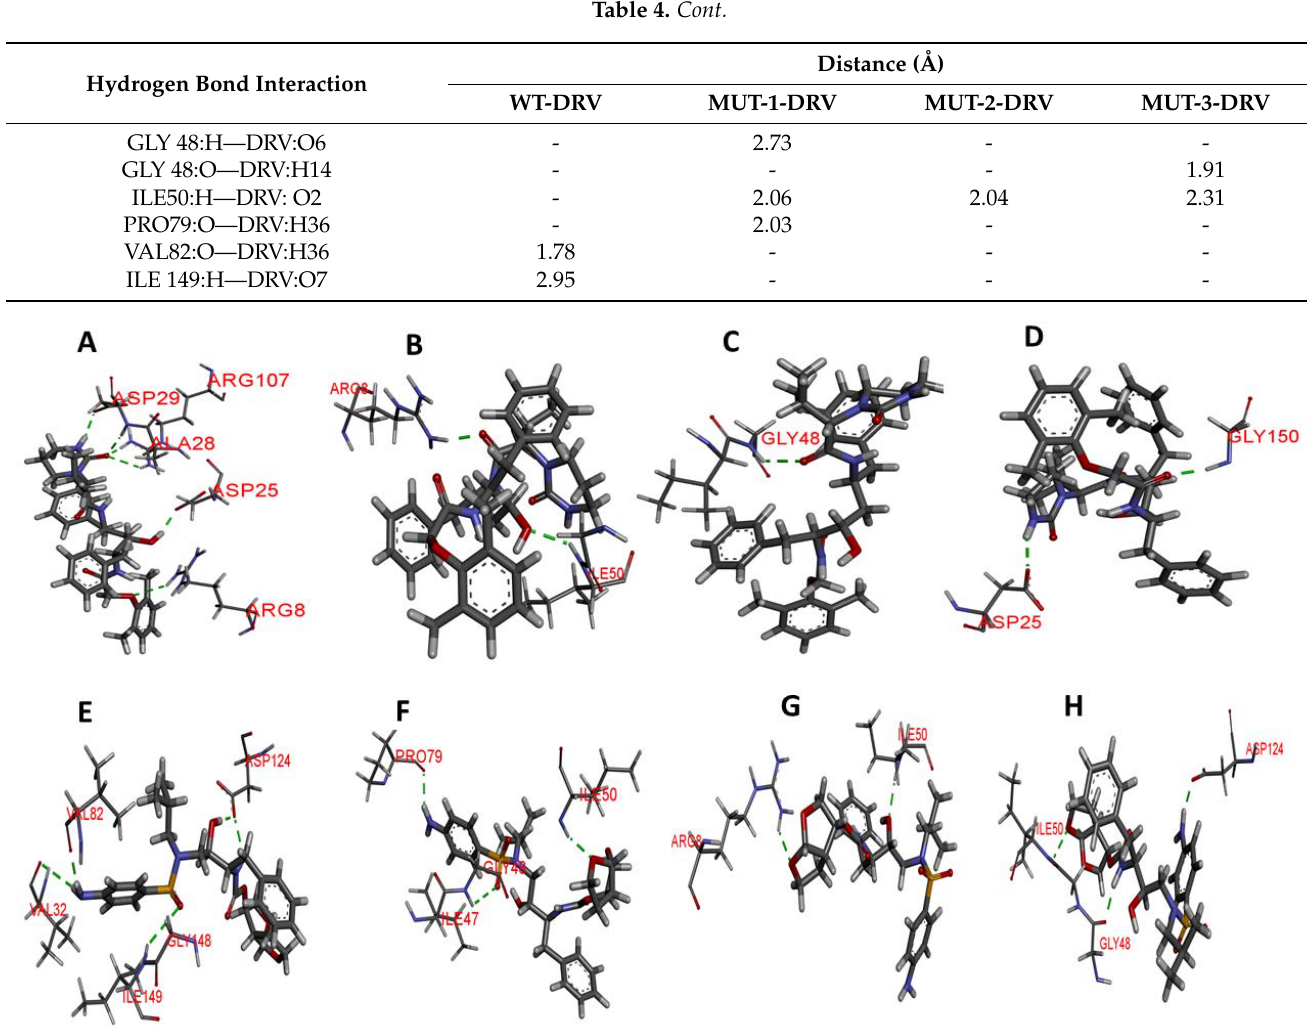
Figure 10. Hydrogen bond interaction of wild type and mutant HIV-1 PR variants with LPV and DRV. The green broken lines represent the hydrogen bond between amino acid residues of HIV-1 PR and the inhibitors and ( A – D ) hydrogen bond interaction of WT, MUT-1, MUT-2, and MUT-3 with LPV, respectively. ( E – H ) Hydrogen bond interaction of WT, MUT-1, MUT-2, and MUT-3 with DRV, respectively.